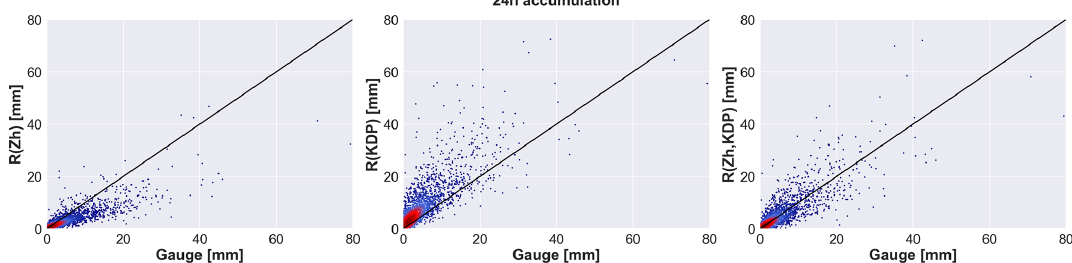
Figure 7. The 24h accumulations for Estonia, 2011–2018. The corresponding verification measures are presented in Table 5. The number of radar–gauge data pairs with eight gauges and accumulations > 0 . 1mm is 2148. Z H is not corrected for attenuation.